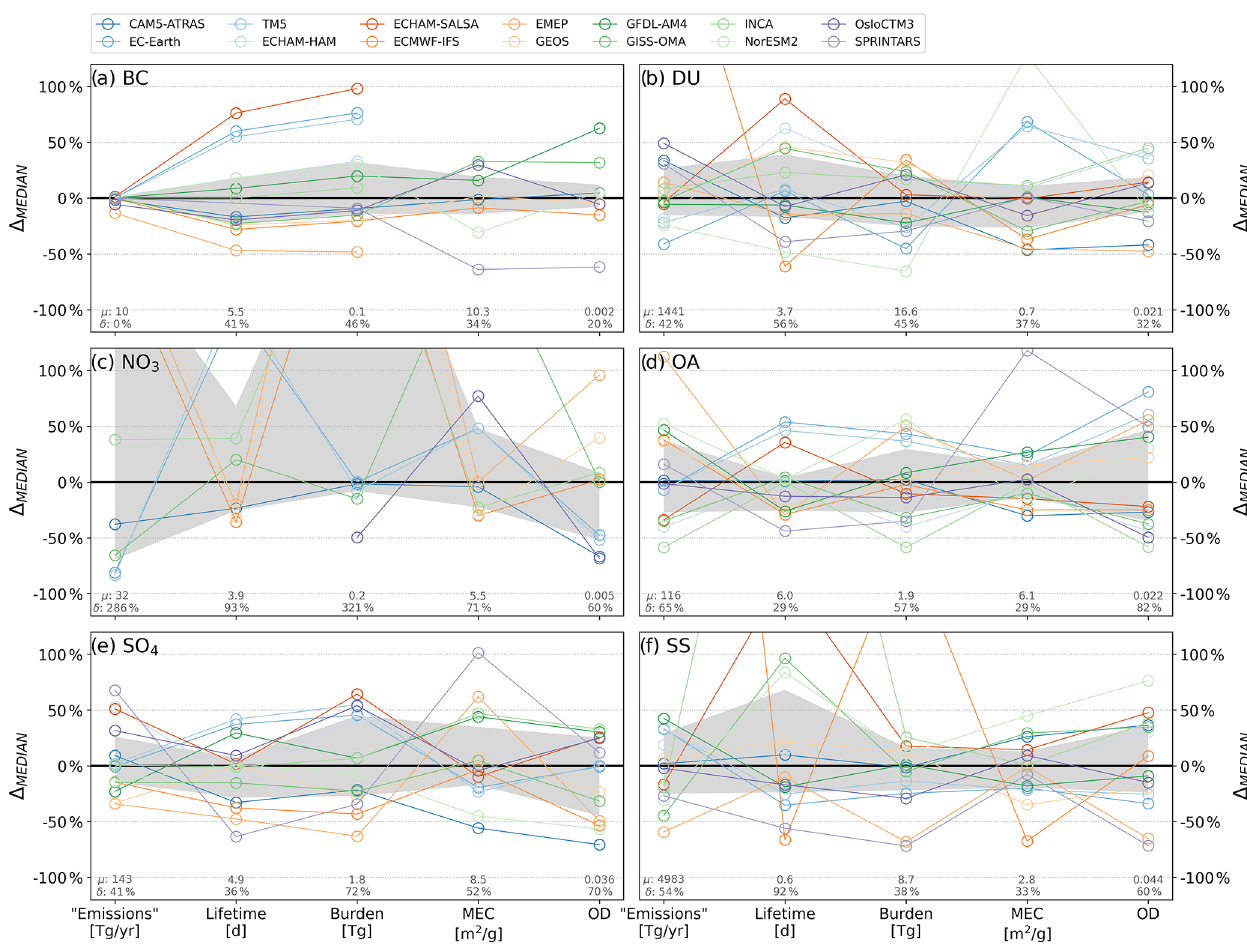
Figure 2. Relation between aerosol life cycle and optical parameters for individual models along with model diversity. The individual panels show model spread of global annual averages for each of the considered life cycle and optics variables ( x axis) and for each model (different colours). The y axis corresponds to the percentage bias from the ensemble median. Also plotted are the model spread (grey shaded area, IQR) as well as the numerical values of median and IQR (in grey colours at the bottom of each subplot; values correspond to Table 3 but may differ due to rounding errors). Note that some models reported erroneous BC MECs and ODs, which are not included here (for details, see Table